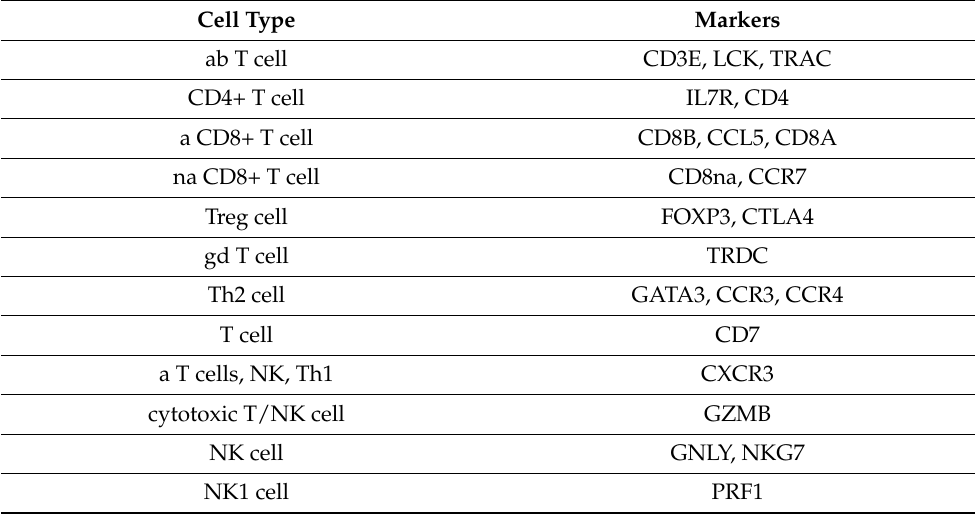
Table A1. Cell types defining gene